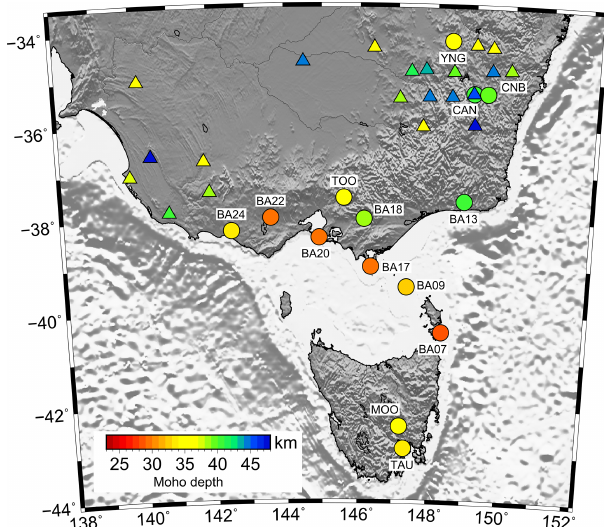
Figure 10. Map showing crustal thickness variations based on the S -wave velocity inversion results of this study (circles) and pre- vious studies (triangles) (Clitheroe et al., 2000; Fontaine et al., 2013a, b; Shibutani, 1996; Tkalcic et al., 2012). The topography and bathymetry are based on the ETOPO1 dataset (Amante and Eakins,